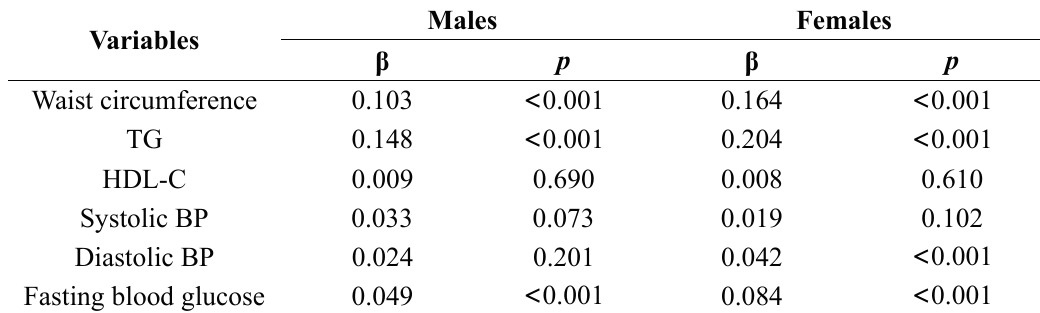
Table 5. Multiple linear regression for all components of metabolic